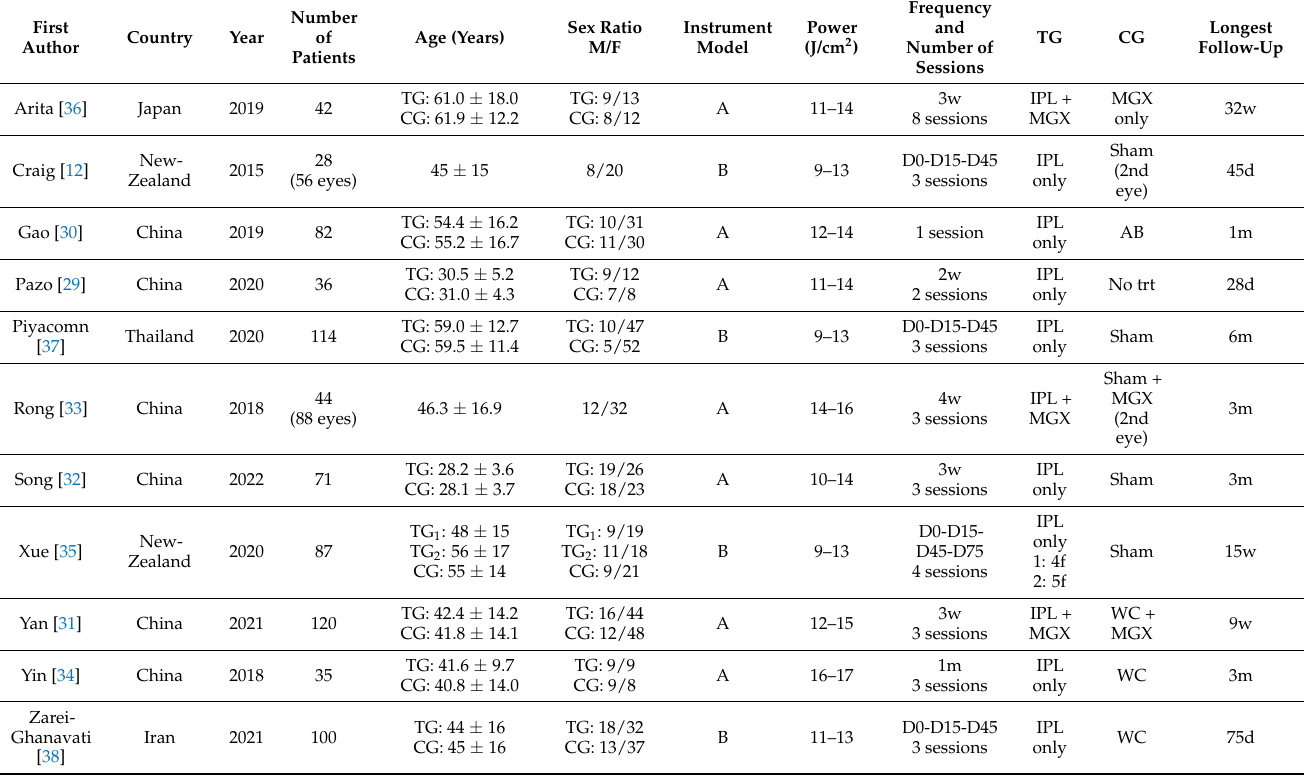
Table 1. Characteristics of the studies included in the